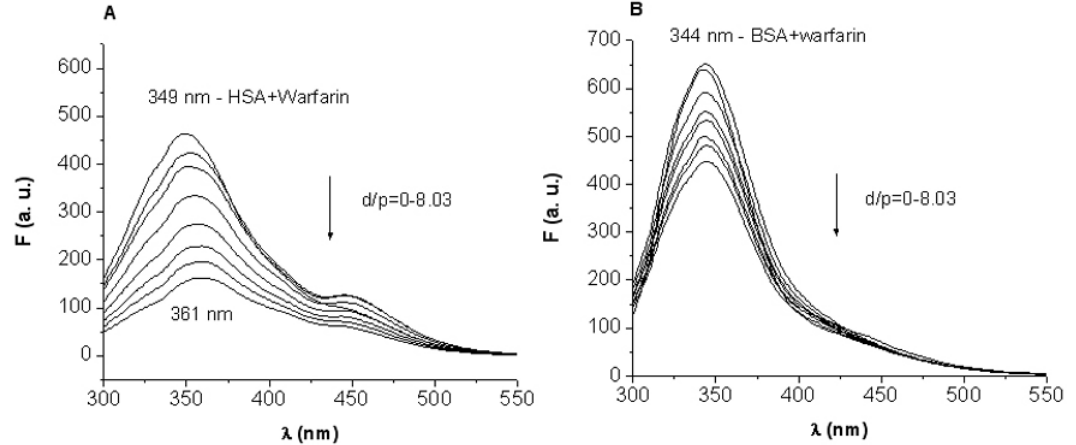
Figure 7. Effect of site marker warfarin to A) (I)-HSA system, [warfarin]=[HSA]=0.75×10 -6 M; B) (I)-BSA system, [warfarin]=[BSA] = 0.75×10 -6 M, T = 298 K, λ = 286 nm, ex